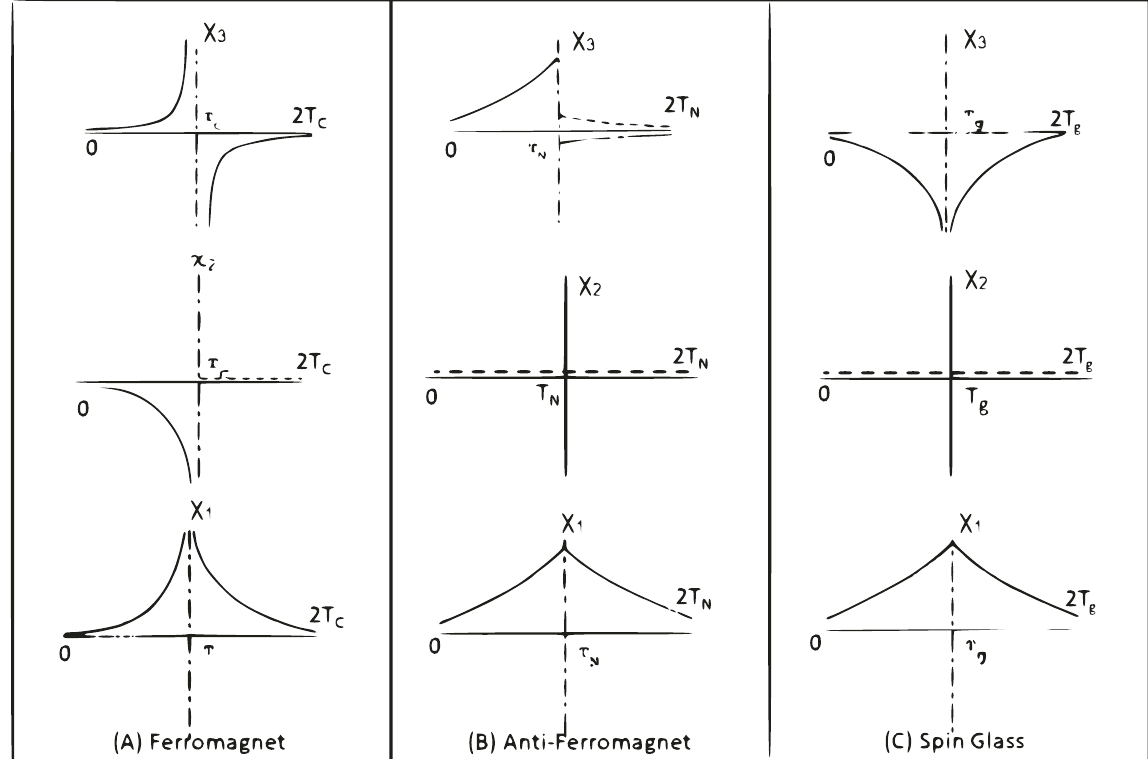
Fig. 1 Schematic of the known qualitative behaviors of the linear ( χ 1 ) and nonlinear ( χ 2 and χ 3 ) magnetic susceptibilities in different fl avors of magnetic systems. In the ferromagnet ( A ) and spin glass ( C ), the nonlinear susceptibility, χ 3 , is negative above the characteristic temperature and has a sharp discontinuity at a characteristic temperature ( T c or T g ). In the anti-ferromagnet ( B ), the sign of χ 3 in the paramagnetic regime depends on the coordination number 25 . Below this temperature, it is observed to rapidly approach zero as T → 0 for all three phases. χ 2 , on the other hand, exhibits such a discontinuity only for ( A ) (e.g., ferromagnet) where time-reversal symmetry is broken 15 . In comparison, in the other two cases it is